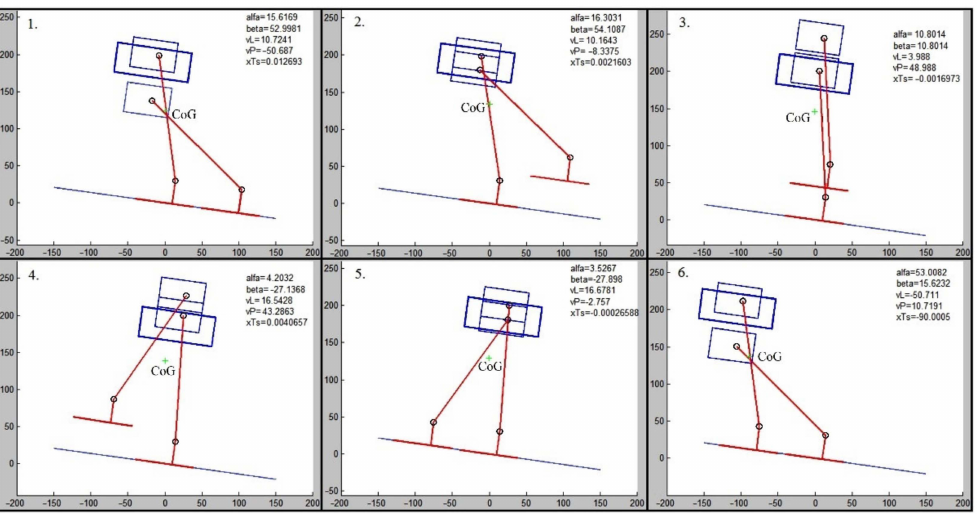
Figure 8. Plotted robot configurations when walking on a pad with a slope of 8 ◦ . Legends: 1—the center of gravity of the robot is above the right foot; 2—the left linear actuator performs the upward stroke of the left foot; 3—the left ankle joint rotates to move the left foot forward and at the same time the right ankle joint balances the robot’s pose to the vertical position of the legs; the right linear actuator also works to keep the base at a constant height; 4—the left ankle joint transmits the left foot forward and at the same time the left linear actuator lowers the foot; the right linear actuator also lifts the base to keep it at a constant height. 5—the left foot is lowered to the ground; 6—both ankle joints rotate so that the center of gravity is transferred above the left foot and at the same time the height position of the base is compensated by the movement of both linear